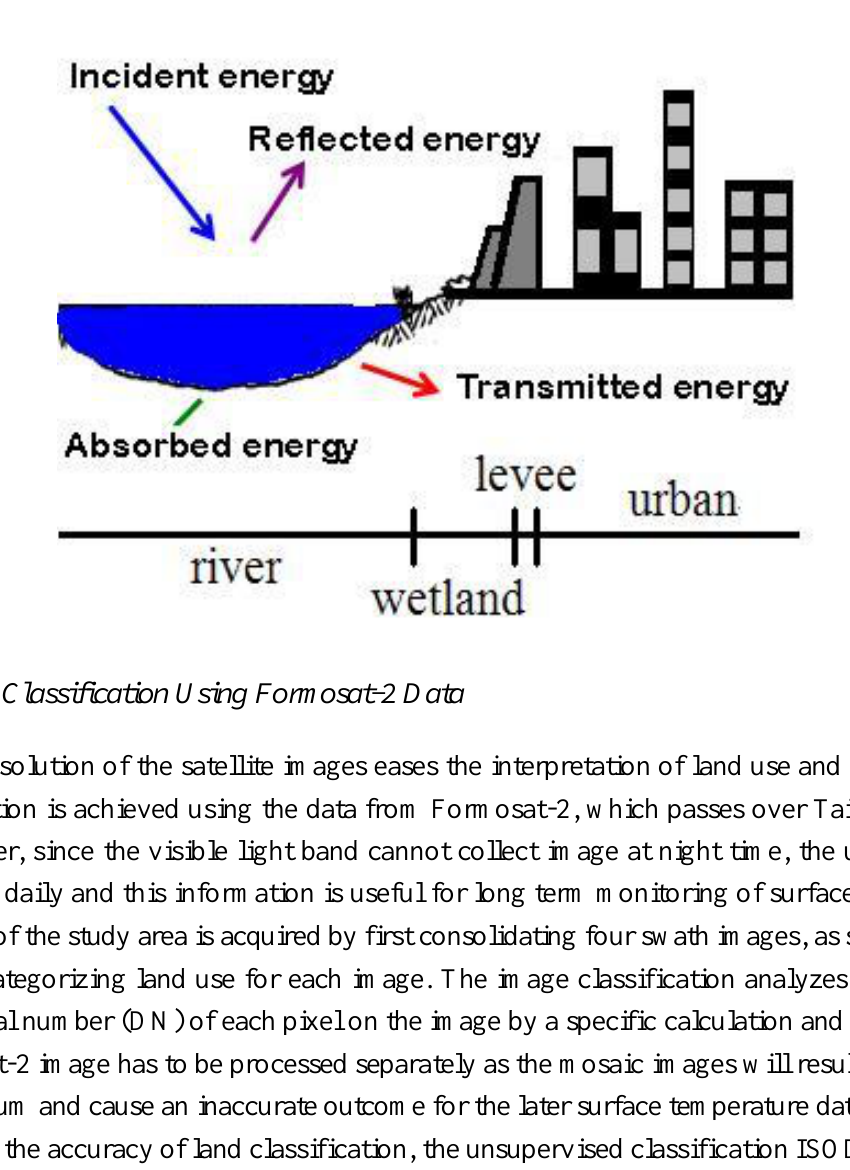
Figure 1. The schematic diagram of solar radiation